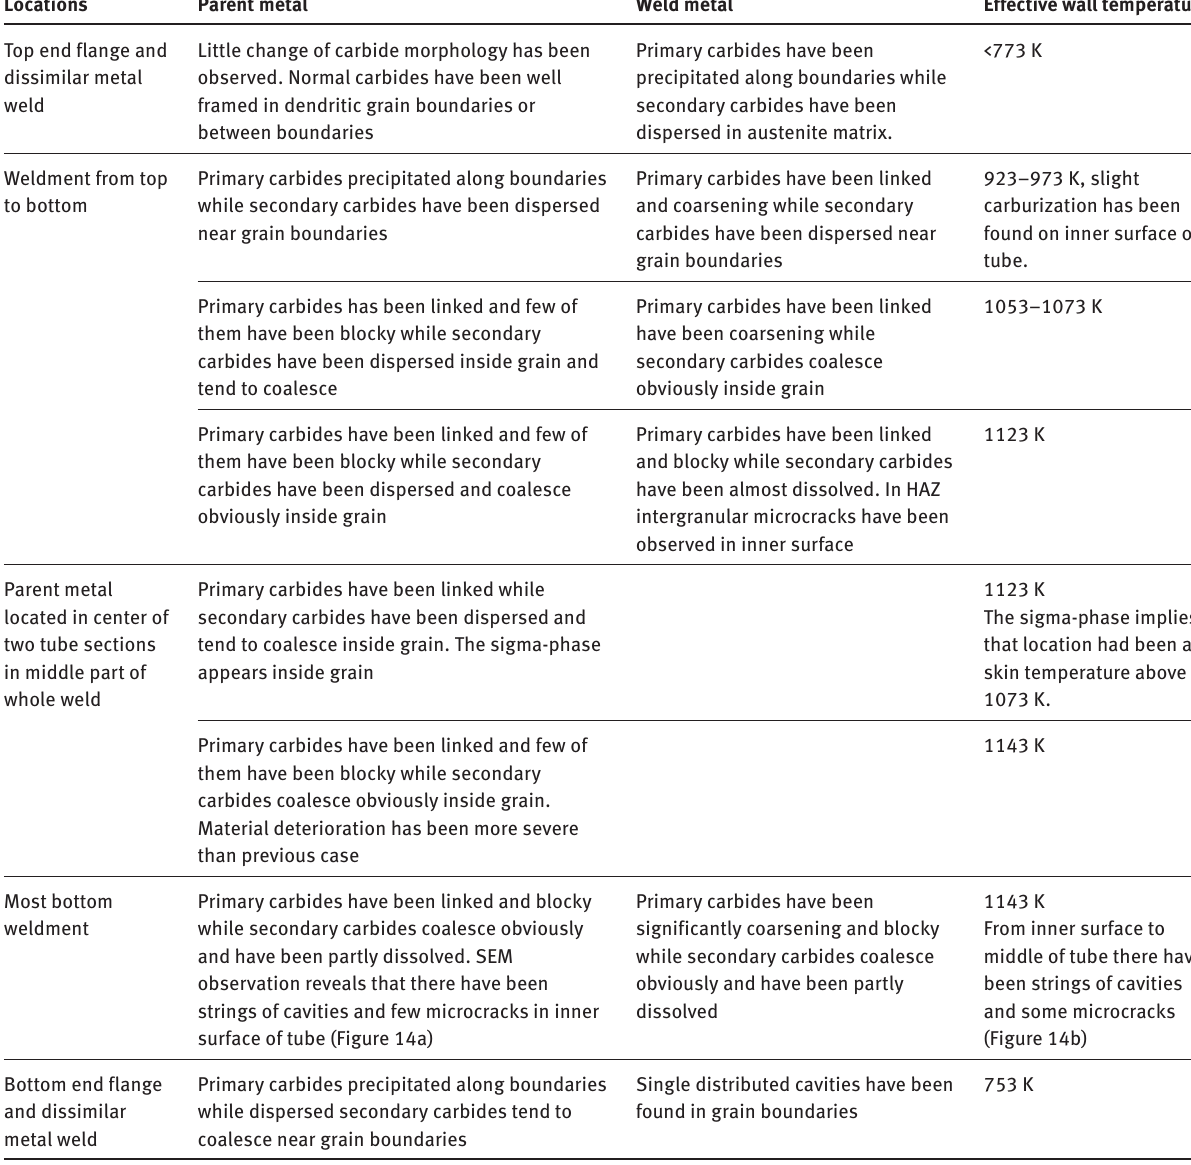
Table 10: Microstructure and effective wall temperature